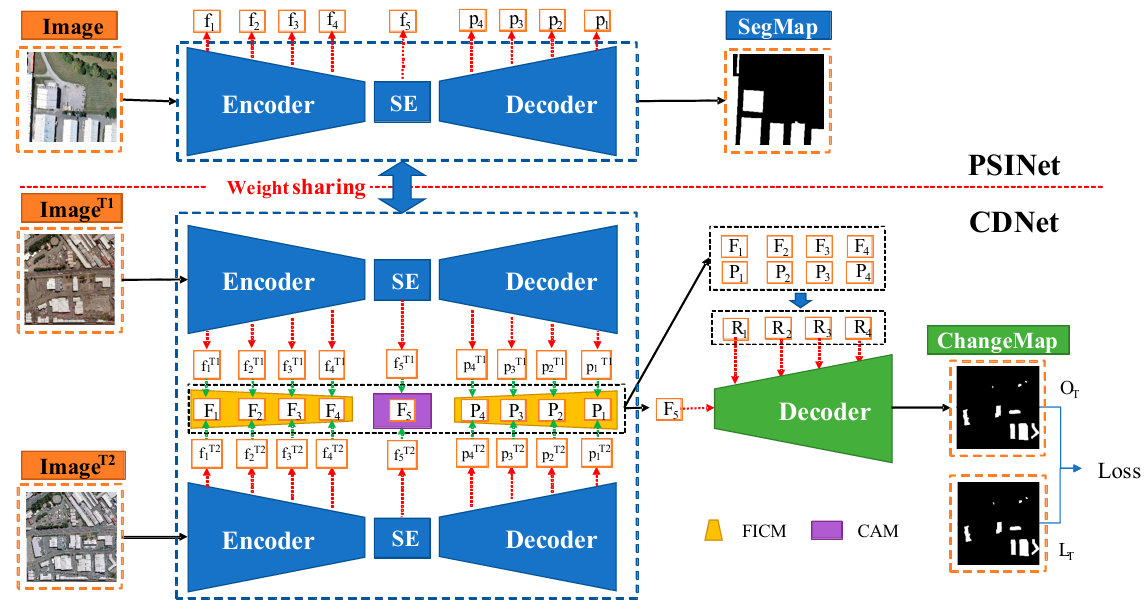
Figure 1. Workflow of the PSI-CD method.